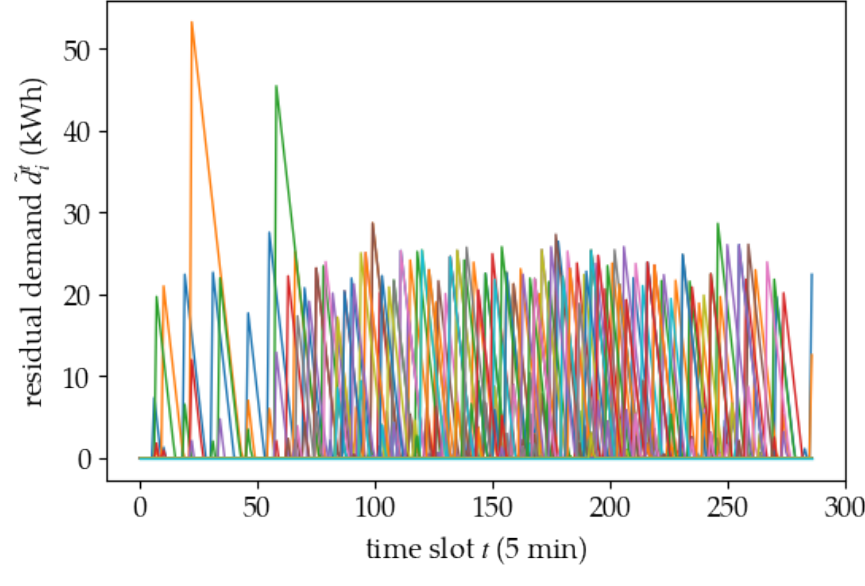
Figure 13. Residual demand per charger (20 in total).